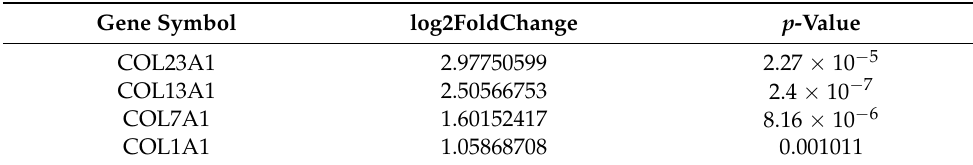
Table 1. DEG analysis comparing COL families among 22Rv1 and chronic intermittent hypoxia- treated cells (22Rv1-CI).